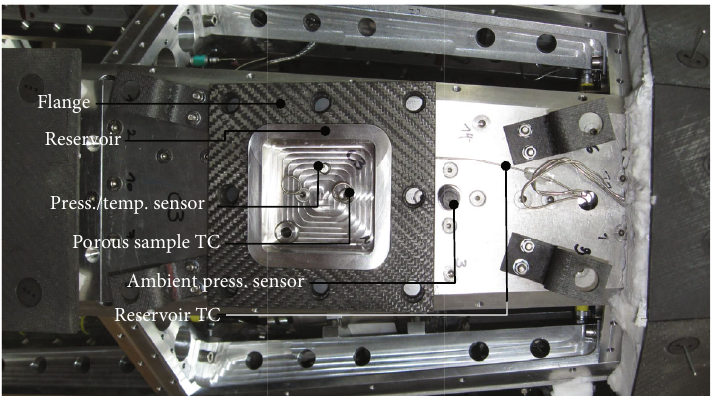
Figure 13: AKTiV interior instrumentation.